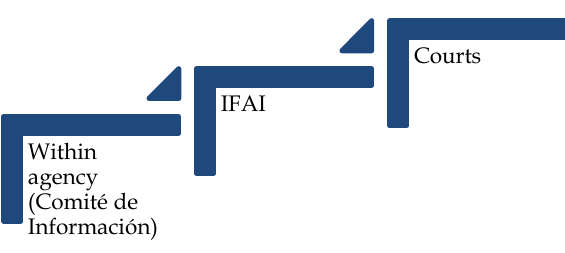
Figure 5: Levels of RTI Appeals in Mexico